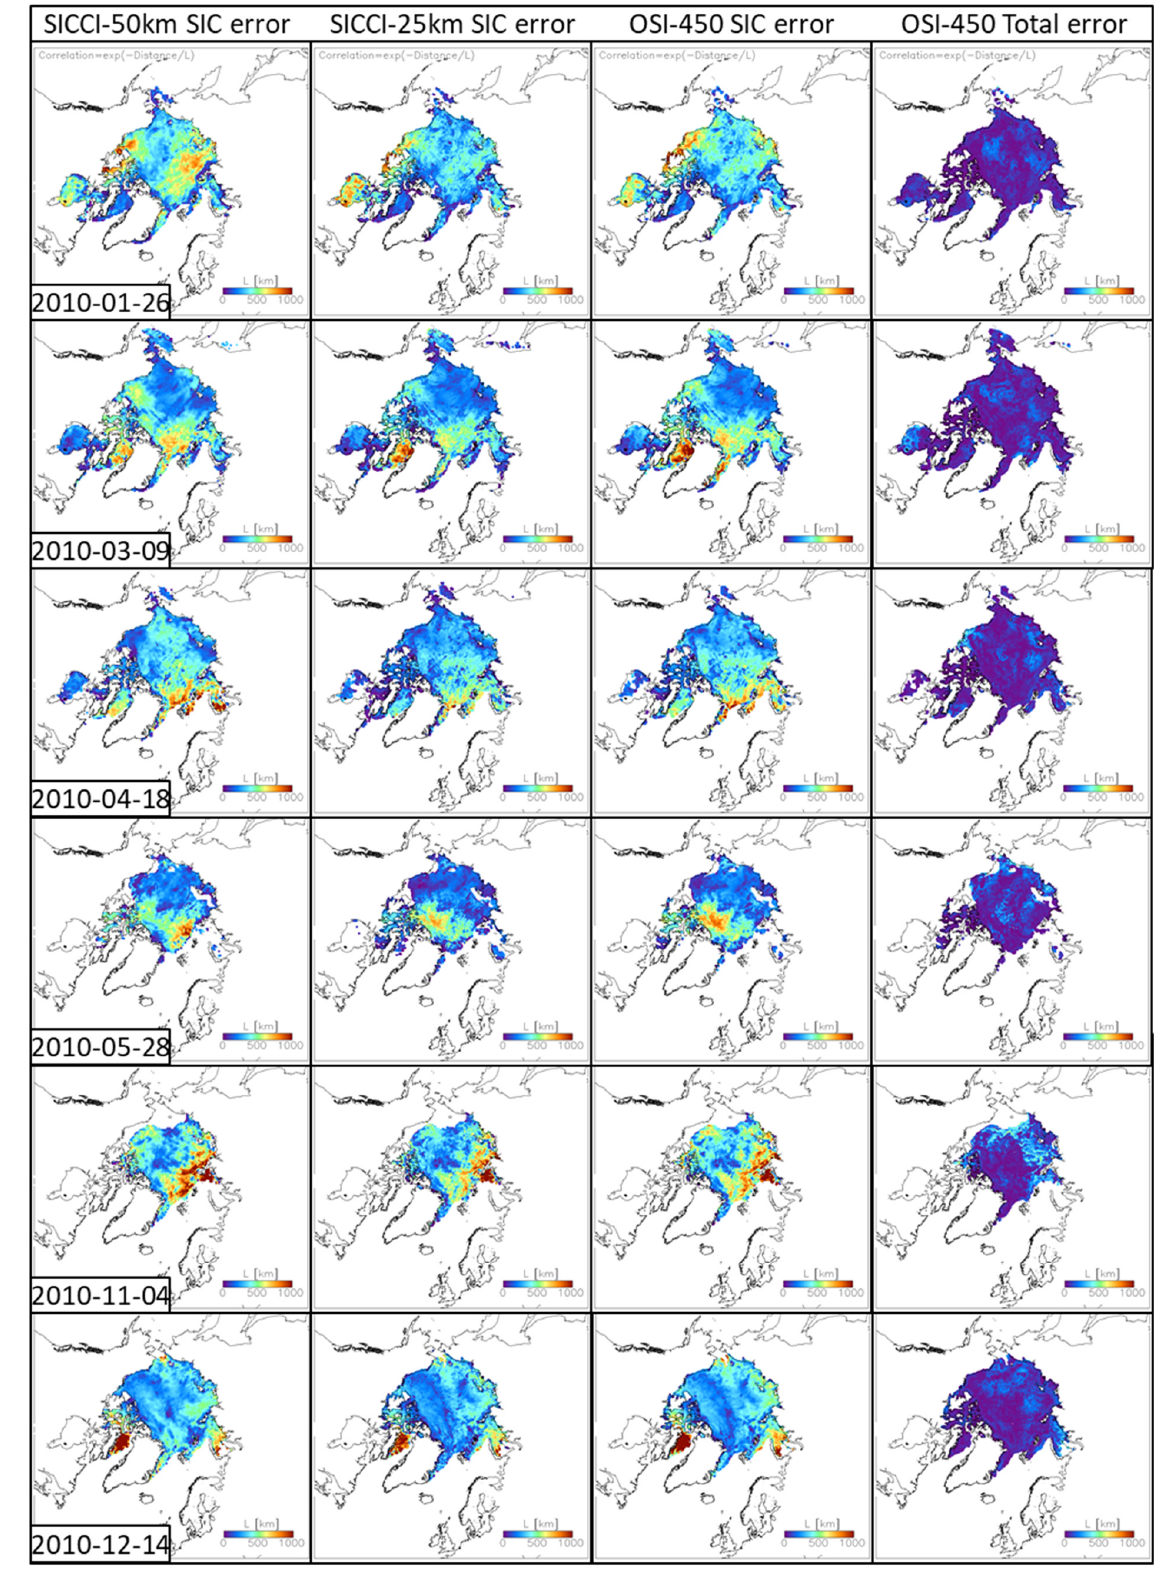
Figure 6. Maps of the SIC error correlation length scale L in kilometers of SICCI-50km, SICCI-25km and OSI-450 (left three columns) and the total error correlation length scale of OSI-450 (rightmost column) in the Northern Hemisphere for the same dates as used in Figure 5, except August and September.